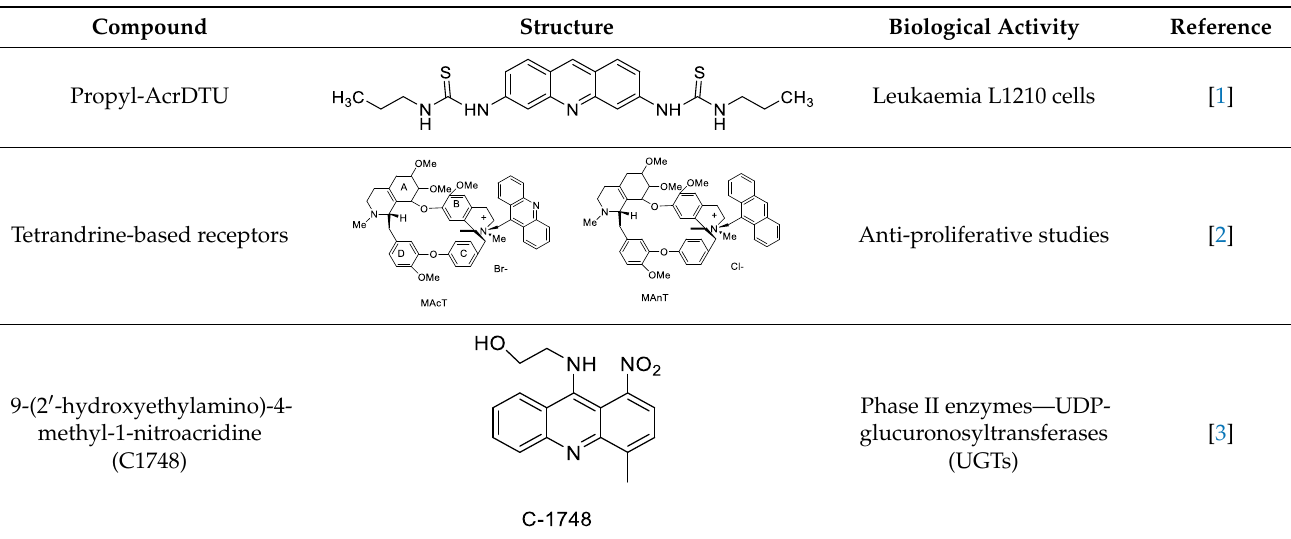
Figure 3. Schematic diagram of acridine as an inhibitor of topoisomerase I and II. Table 1. Acridine as an anti-tumour agent.